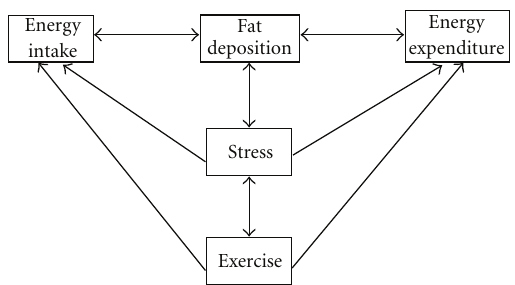
Figure 2: Potential influence of exercise on the interaction between stress and